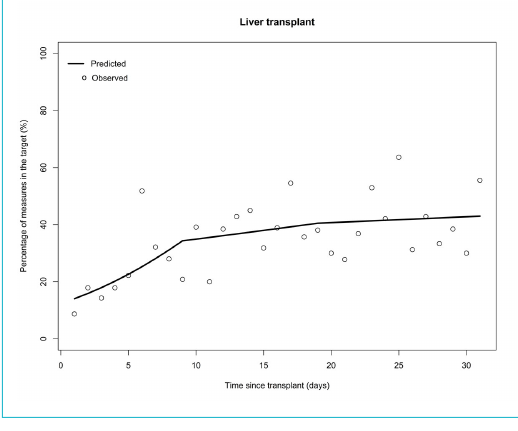
Figure 2: Probability of tacrolimus trough level being in the target range in the first month after liver transplantation.